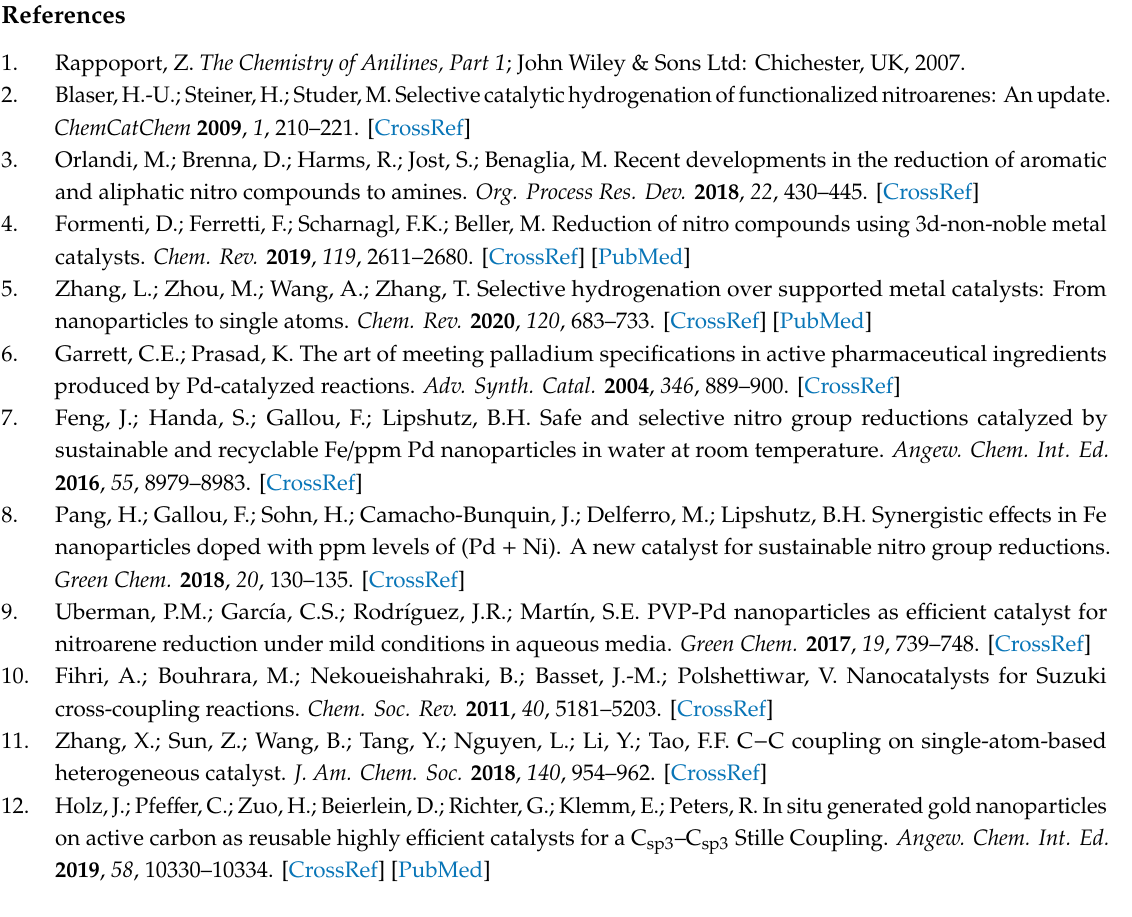
Figure S1: standard curve; Figures S2–S6: XRD analysis; Figures S7–S9: TEM and SEM analysis; Figures S10 and S11: XPS analysis; Table S1: summary of XRD results and 1 H and 13 C NMR spectra